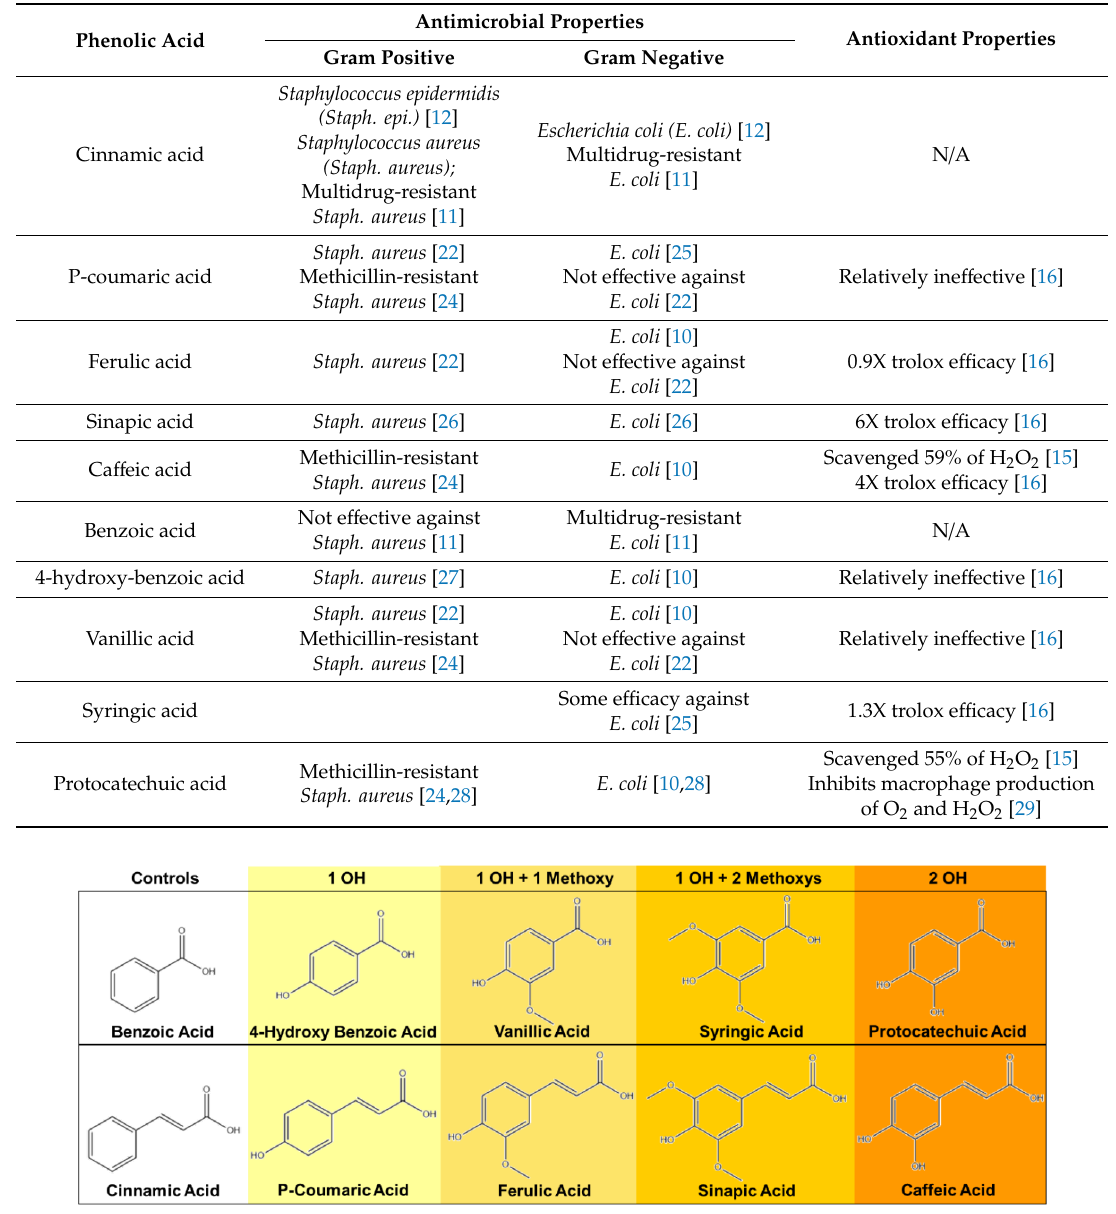
Figure 1. Chemical structures of 10 selected phenolic acids (PAs). Top row: benzoic acid (BA)-based PAs; bottom row: cinnamic acid (CA)-based PAs.